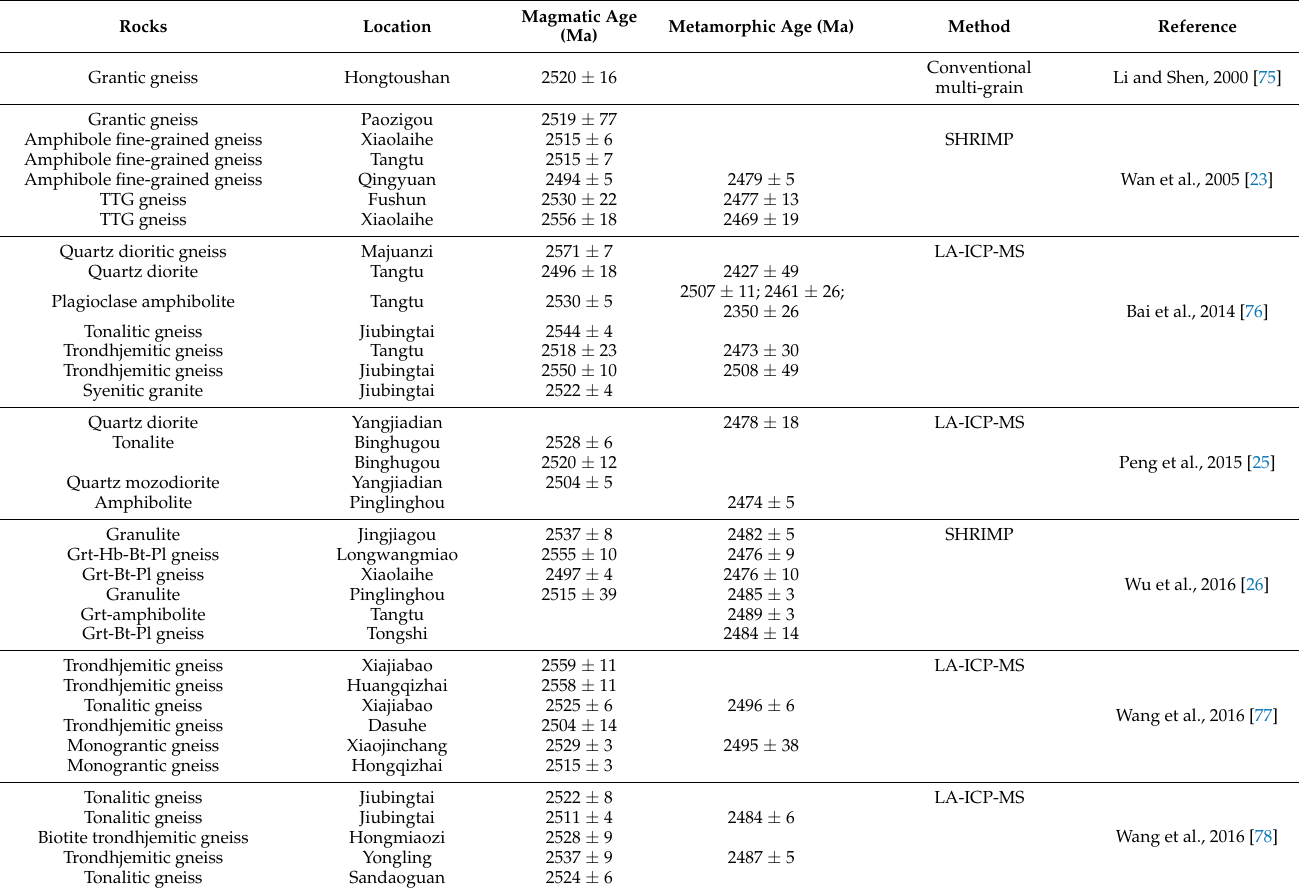
Table 3. Summary of metamorphic ages of supracrustal rocks and magmatic ages of TTGs in the Qingyuan